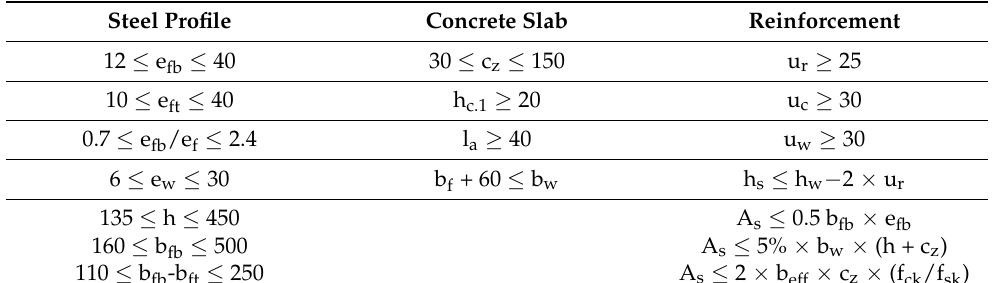
Table 3. Application range—Geometric limits for asymmetric double-T